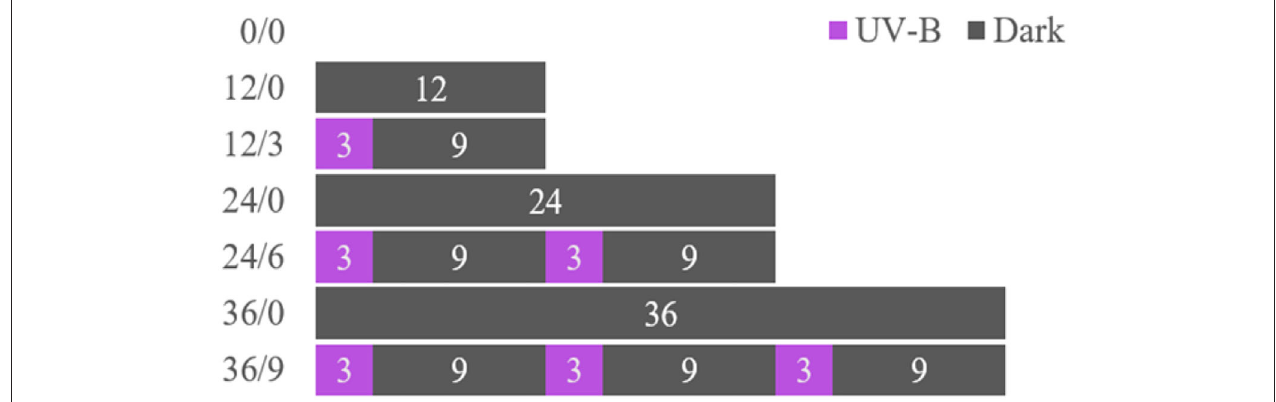
FIGURE 1 | Experimental scheme for the preparation of wheat kernels treated with UV-B. Germinated wheat was treated with UV-B radiation (0, 3, 6, and 9h) over different time intervals (0, 12, 24, and